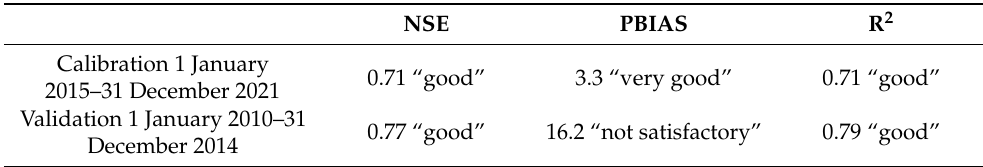
Table 4. Calibration output; classification of evaluation parameters after Moriasi et al. [75] for daily stream flow data at subbasin